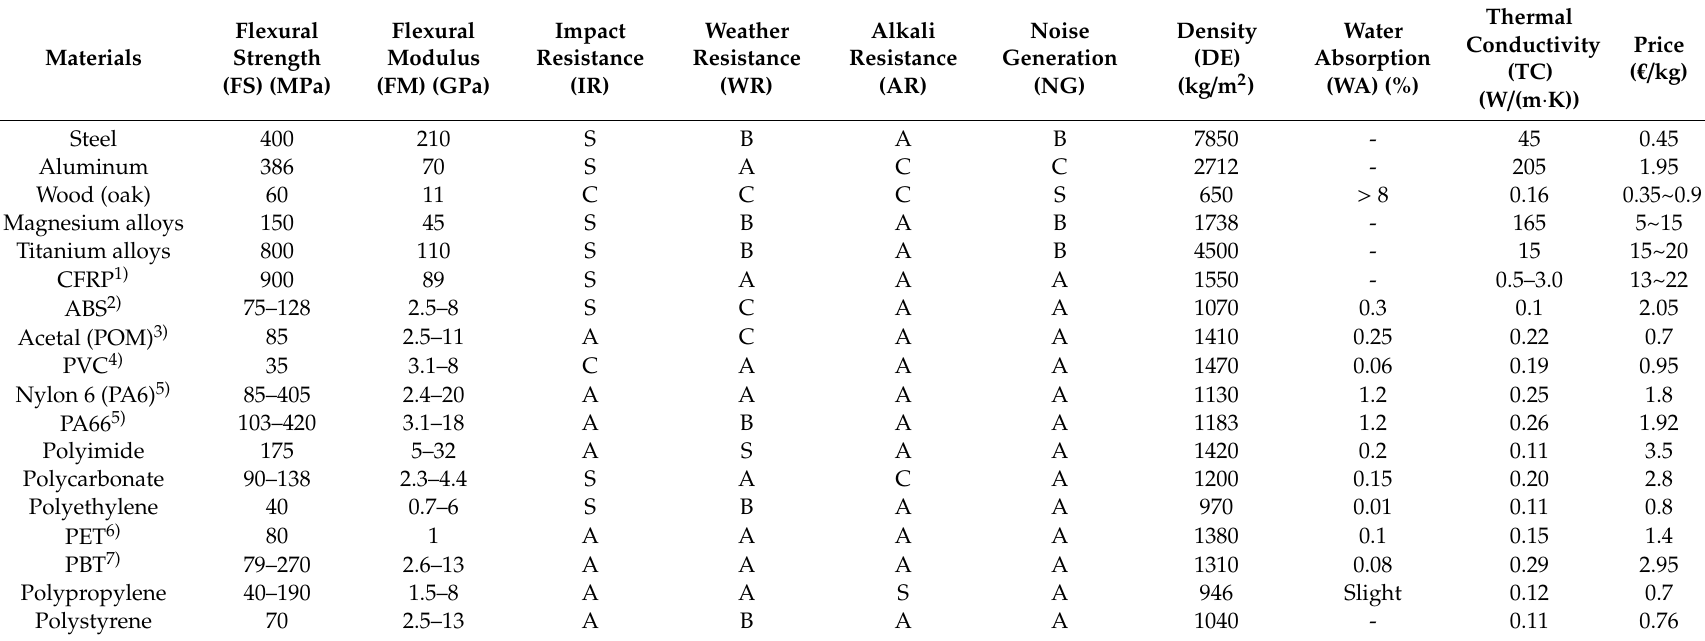
Table 6. Allowable formwork material properties according to the performance